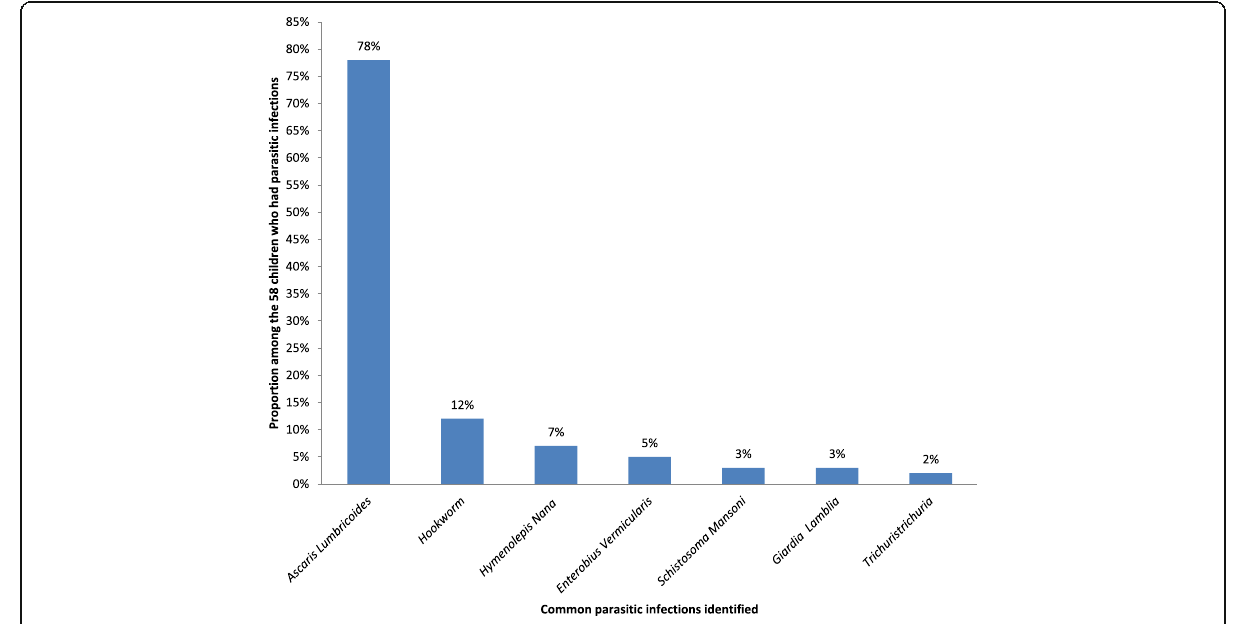
Fig. 1 Common intestinal parasitic infections identified among children aged 6 – 59 months in rural Dembiya, northwest Ethiopia, May